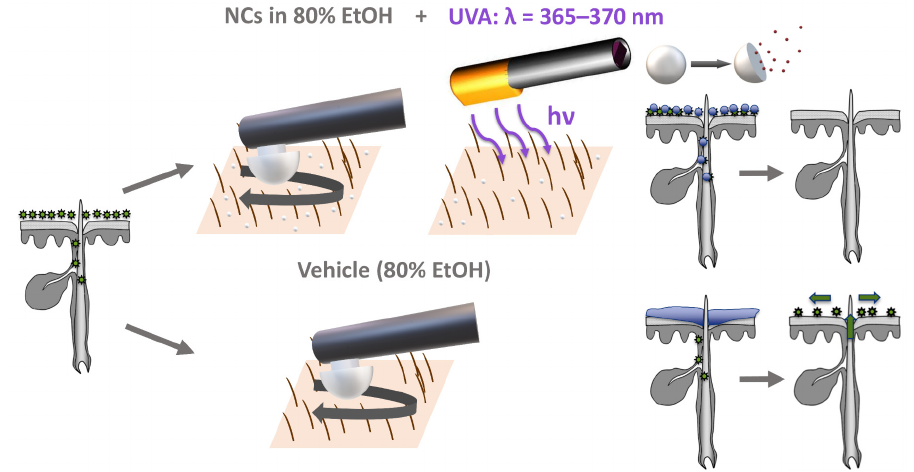
Figure 1. Application of the hydroxyethyl starch nanocapsules (HES-NCs) in 80% ethanol (EtOH) on colonized ex vivo porcine skin with a massage device and subsequent irradiation of the skin surface with a novel LED device emitting at a peak wavelength of 365–370 nm which leads to an intrafollicular release of EtOH from the HES-NCs resulting in a decolonization of the skin surface and the hair follicles. After application of the pure vehicle (80% EtOH) the skin surface is decolonized but the risk of a recolonization of the skin from deeper parts of the hair follicle